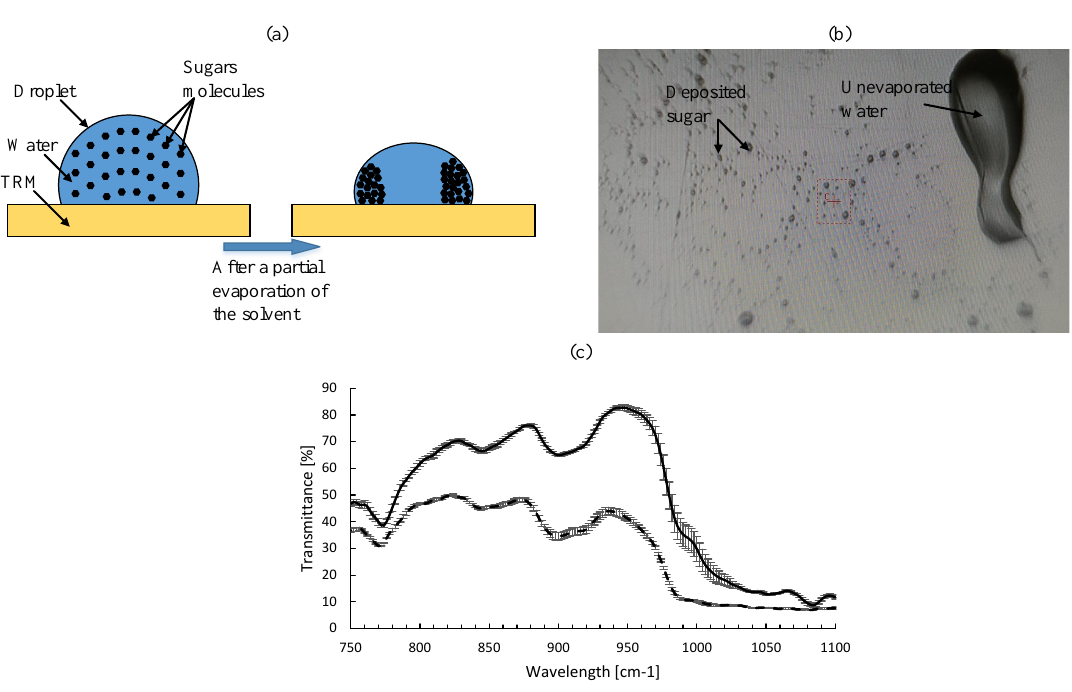
Figure 2. ( a ) Schematic representation of the difference between the molecular distribution in the droplet before and during the solvent evaporation using the standard SHS. ( b ) Deposited sugar on a standard SHS after water evaporation. ( c ) Two recorded absorption spectrum of two sugar samples taken from the same sugar solution.